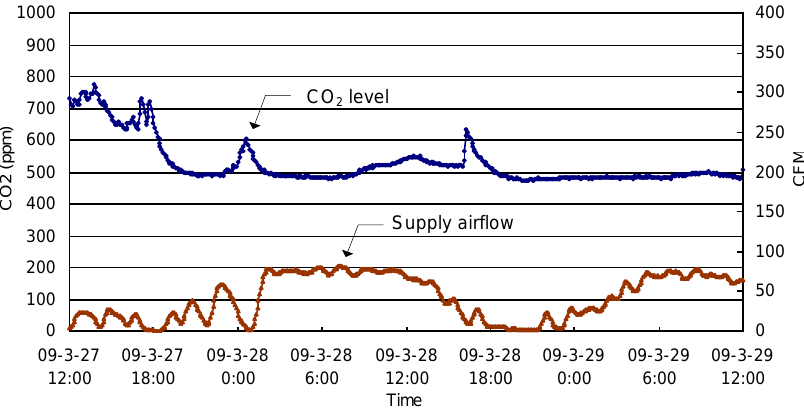
level and airflow rate. 2